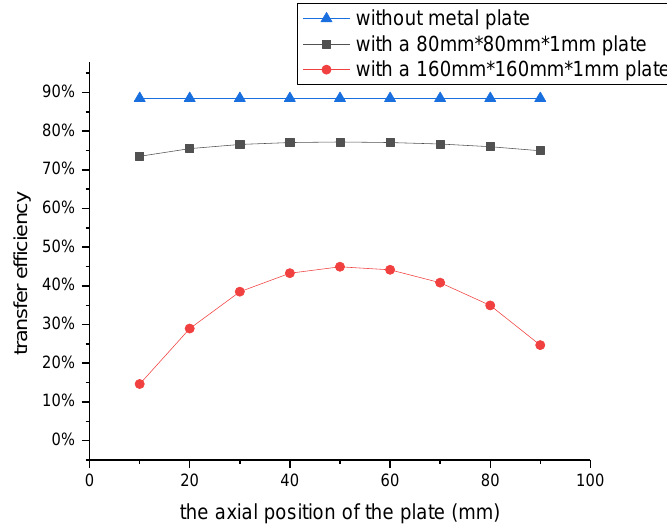
Figure 3. The variations of the efficiency with the position of the plate.